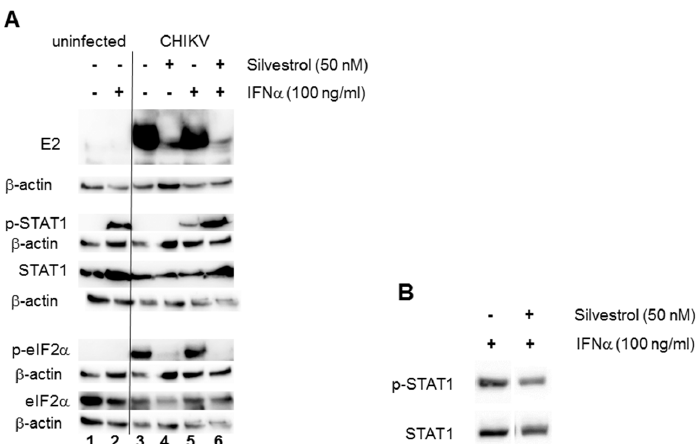
Figure 3. Analysis of signal transduction during CHIKV infection in the presence of 50 nM